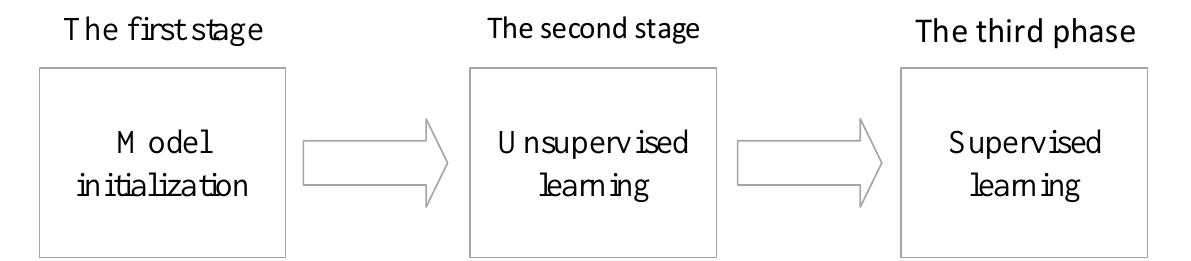
Figure 3. Deep Belief Net (DBN)model training.